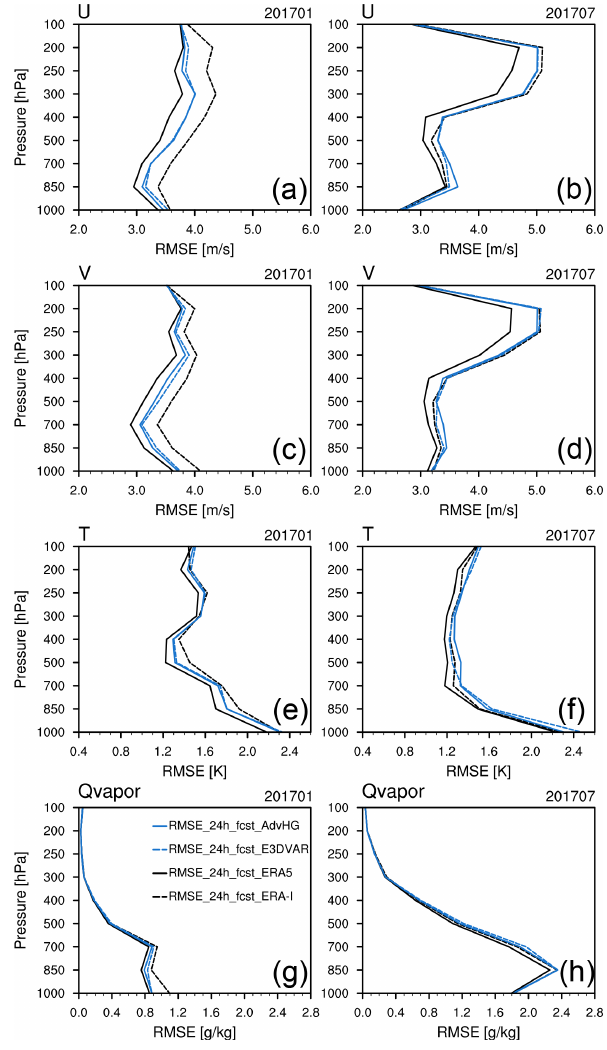
Figure 4. The same RMSEs as in Fig. 3, except for 24h